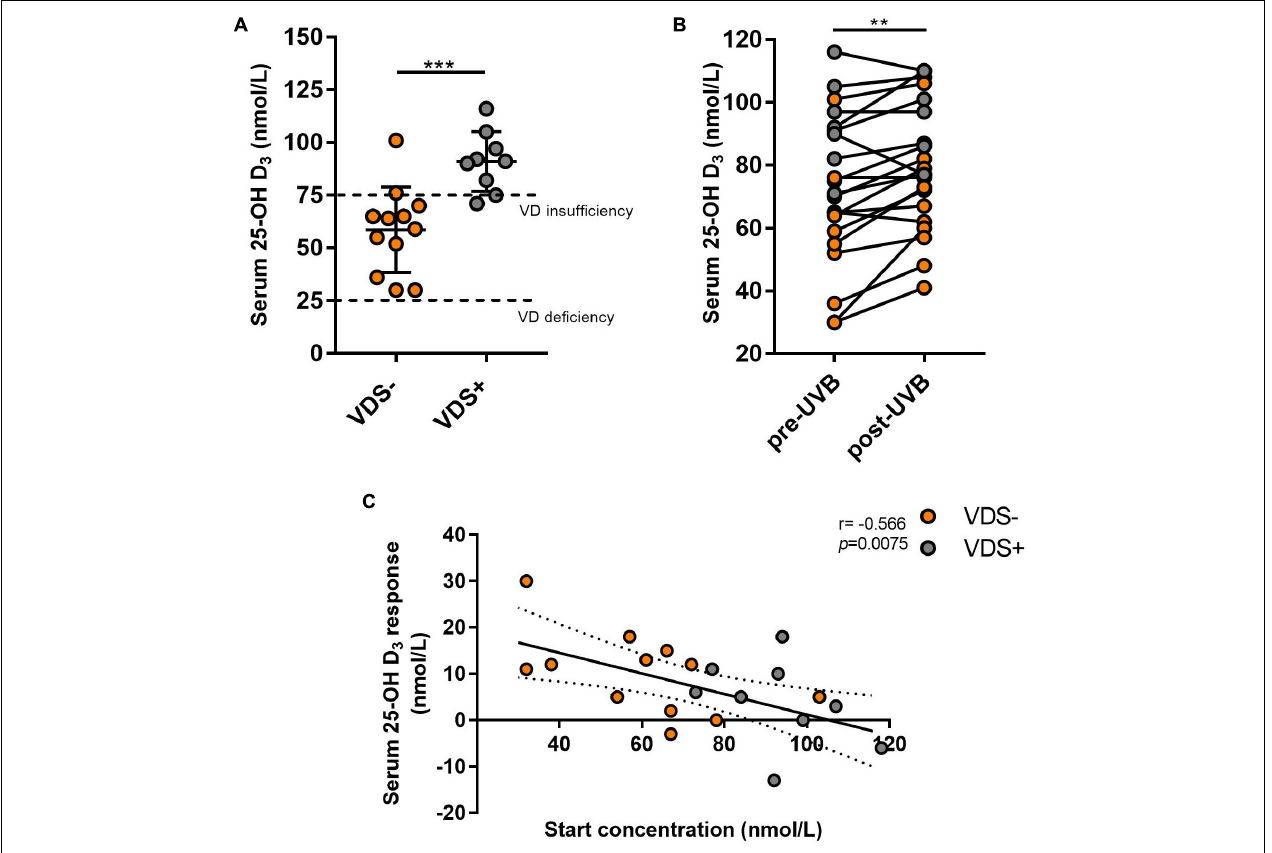
FIGURE 1 | Serum 25-(OH)D response after UVB light exposures. (A) The serum concentrations from the VDS − group was significantly lower than the VDS + group prior to the UVB light exposures (unpaired t -test p = 0006). (B) Serum 25(OH)D concentration values pre and post-UVB exposures, significance was calculated using a paired t -test of repeated measures ( p = 0.002). (C) The correlation between the serum 25(OH)D response and the 25(OH)D at the start of the study. A negative correlation was calculated with a Pearson correlation analysis ( r = − 0.566; p = 0.0075). ∗∗ p < 0.001, ∗∗∗ p <